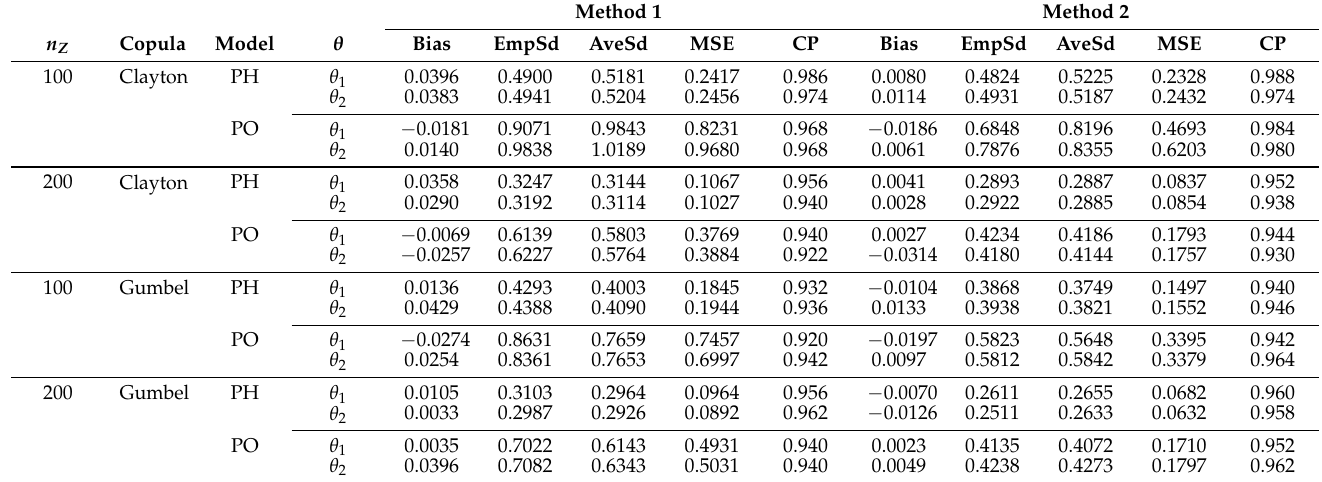
Table 7. The estimators of θ under Case 2 with τ = − 0.05 when the variable of interest is X.